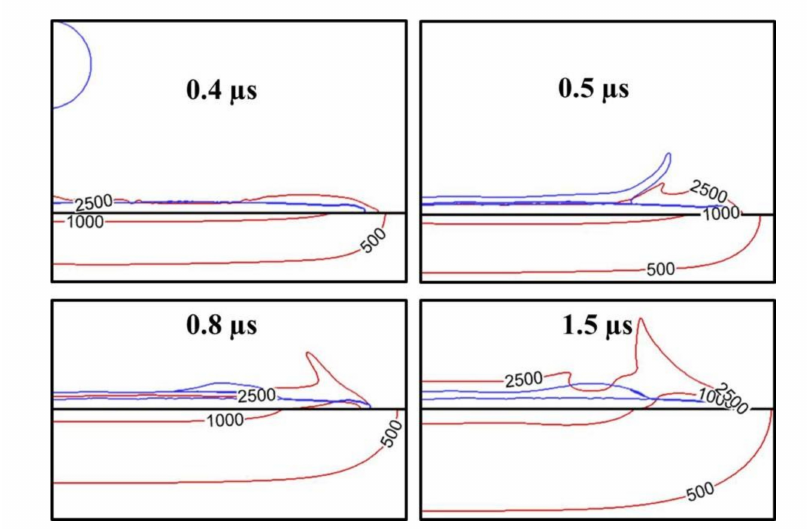
Figure 12. Temperature distribution of sequential refinement droplets after impacting on a substrate at 518 m / s. (The red represents the isothermal line and the blue YSZ